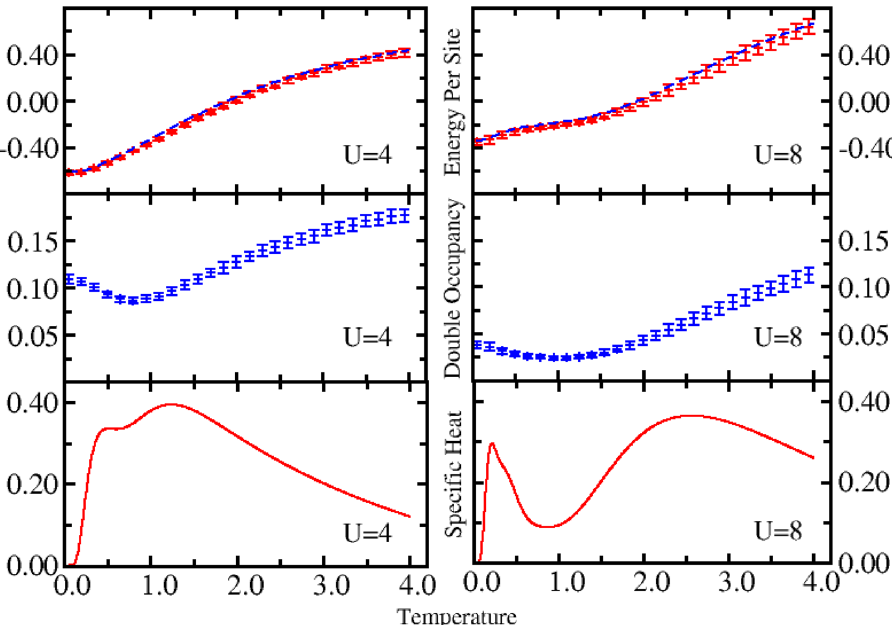
Figure 5. Energy (upper panels), double occupancy (middle panels), and specific heat (bottom panels) as a function of temperature for U = 4 (left panels) and U = 8 (right panels) of the system with six lattice sites. The QMC results (symbols) are in excellent agreement with the exact value (dashed lines) across the entire range of